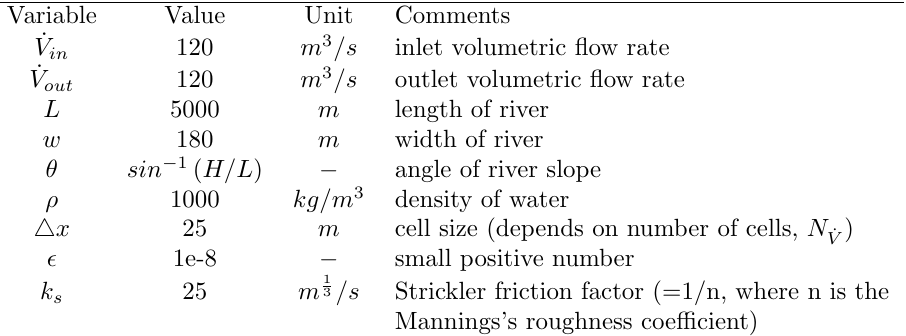
Table 2: Parameters of the river flow system.